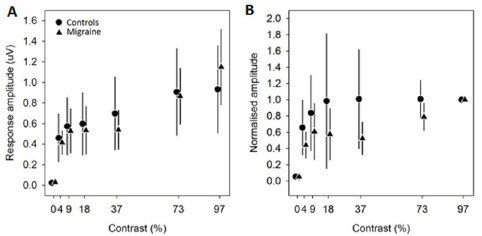
Fig 3. Contrast response gain functions. Contrast response gain functions shown in terms of the raw EEG response amplitude (A) and normalised to individual responses at 97% checkerboard (B). Symbols represent group averaged data (controls: circles, migraine: triangles) with error bars as 95% confidence intervals of the